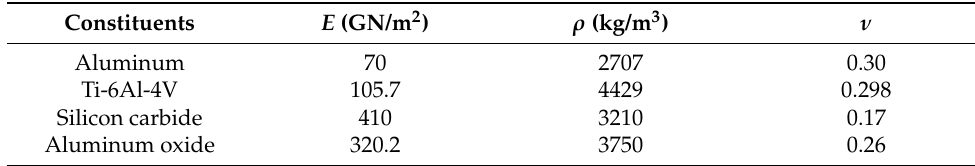
Table 1. Properties of the FGM constituents [1,10].